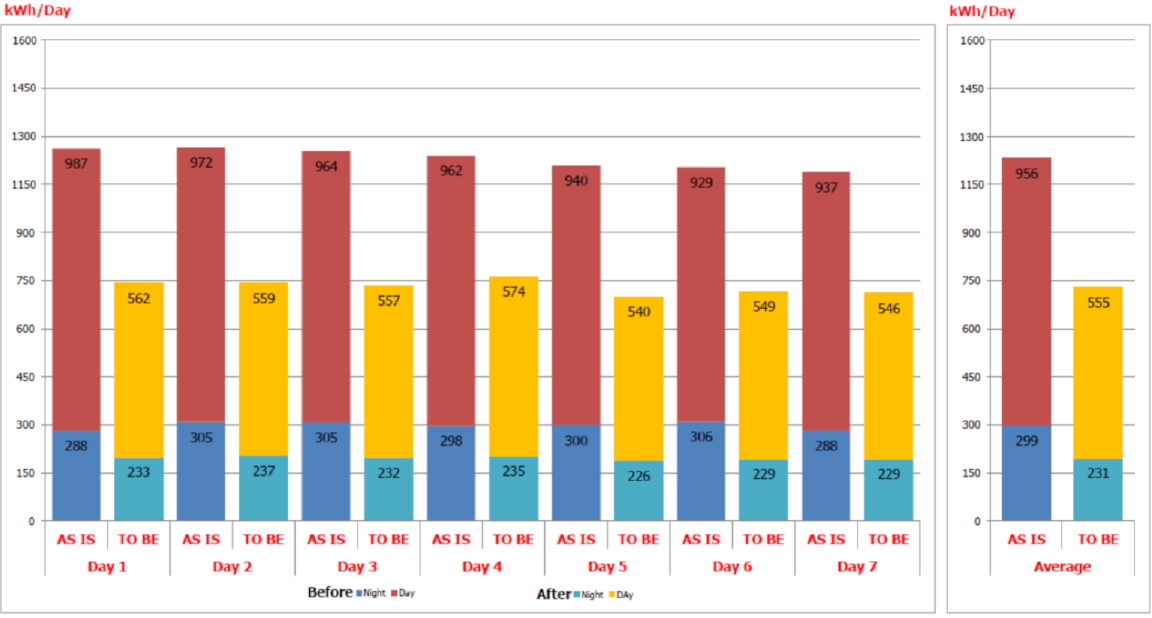
Figure 7. Average power consumption per day before and after door retrofits for store No.2 (R404A). As shown in Figure 8, the maximum and minimum energy consumptions before door installation were 83.25 kW and 44.73 kW, respectively, showing a difference of 46.72%. After installing the door, Figure 9, the highest and lowest energy consumptions before door installation were 33.15 kW and 30.19 kW, respectively, showing a difference of 8.93%. Installing the door led to a reduction in uncontrolled external factors during the day and at night, but a smaller difference in energy consumption was observed, meaning that energy can be saved. Economic results from testing at a 3000-square-meter